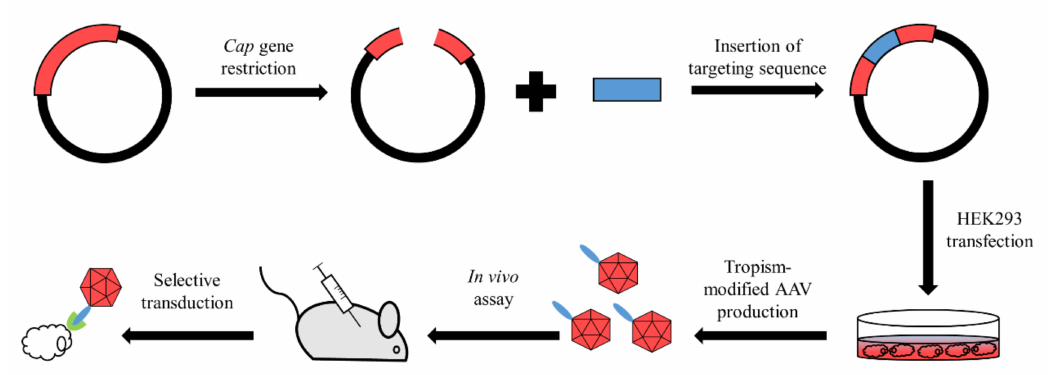
Figure 2. Generalized steps of AAV rational design. Red line represents Cap gene inside of plasmid. Digestion of Cap gene in the insertion site allows a targeting sequence to be plugged inside of the gene. Further steps lead to production of tropism-modified AAV which is able to transduce target cells either in or ex